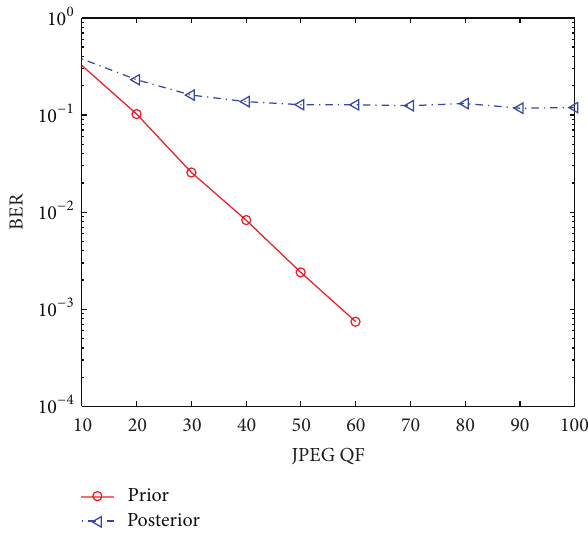
Figure 3: Performance comparison between the prior- and posterior-HMM-based informed watermarking